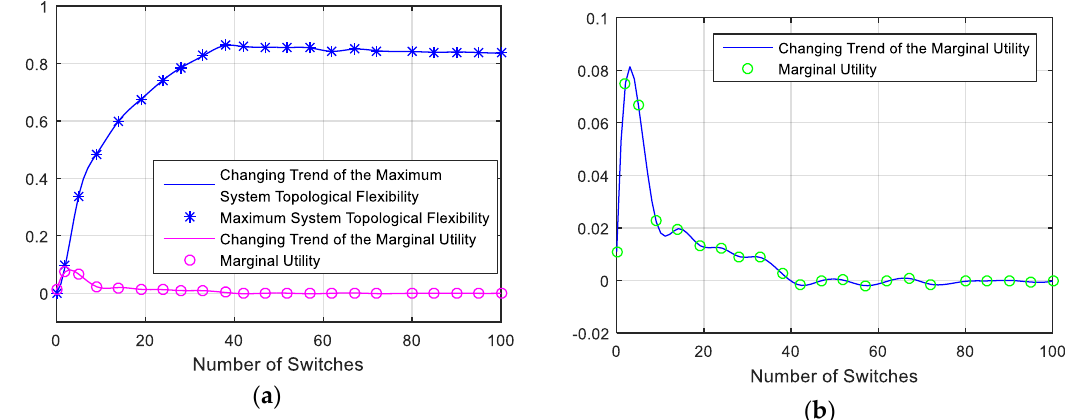
Figure 8. Analysis of the maximum system topological flexibility after the topological flexibility metric is revised. ( a ) Maximum system topological flexibility and its marginal utility; ( b ) marginal utility of the maximum system topological